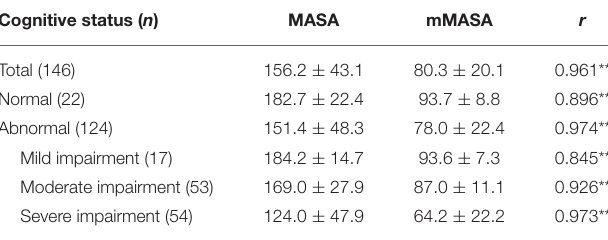
TABLE 2 | Correlation between MASA and mMASA according to cognitive status. Cognitive status ( n )